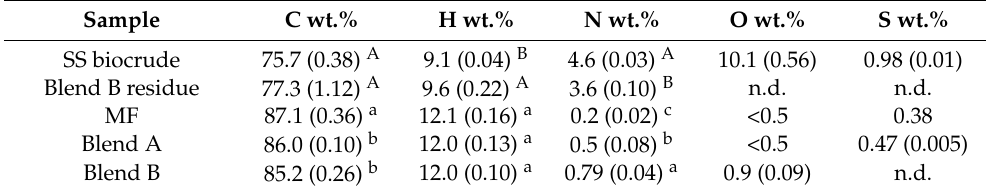
Table 2. Carbon, hydrogen, nitrogen and oxygen content of SS biocrude, MF and blend samples (Blend A, B, and B residue). Values are the means ( n = 3) with corresponding standard deviation between brakets. Statistically significant differences ( p < 0.01) between mean values are shown with distinct letters. Capital letters ( A,B ) indicate statistically significant differences between SS biocrude and Blend B residue, lower-case letters ( a–c ) indicate statistically-significant differences between MF, Blend A and Blend B. Sample C wt.% H wt.% N wt.% O wt.% S wt.% SS